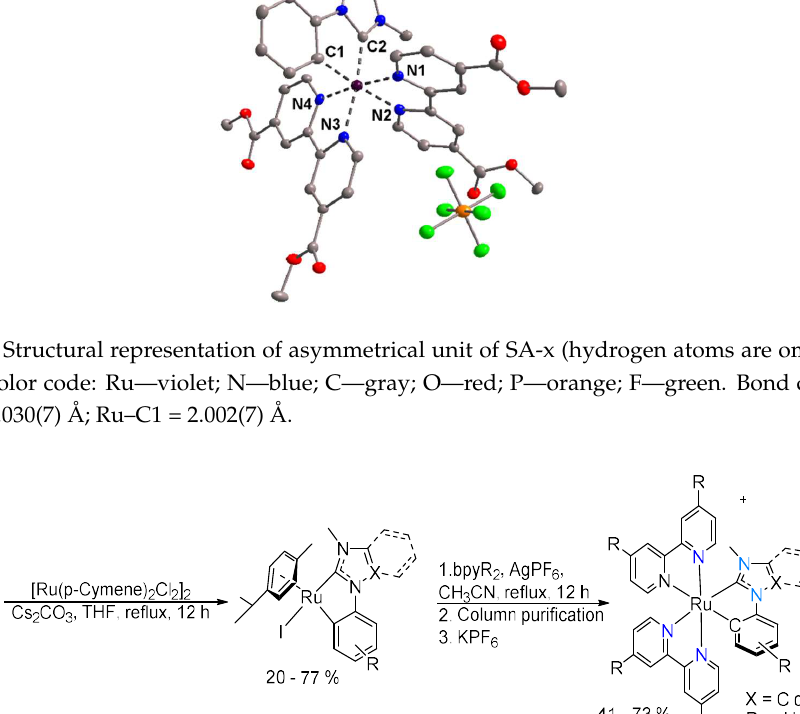
Scheme 5. Synthesis of new cyclometalated ruthenium complexes with N -heteroleptic carbene